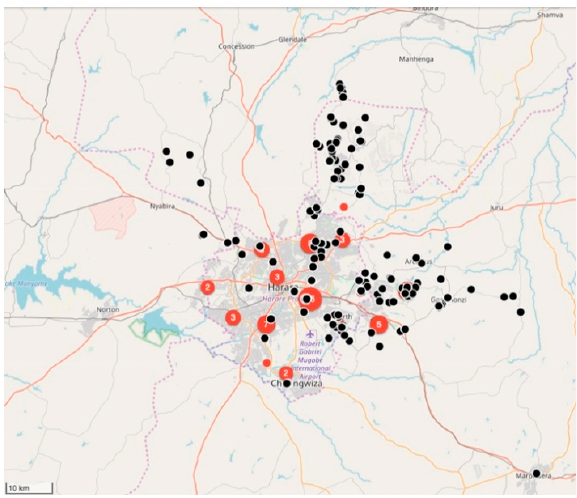
Figure 5. Map of Harare showing the location of laboratory-confirmed rabies cases (red dots) and locations of vaccinated animals (black dots) in 2018. The number of rabies cases per location is displayed in terms of the size and the number within each red dot. Only the location of the vaccinated animals is displayed on the map (black dots) for ease of interpretation. On this specific map, the total number of black dots represent the 9617 animals vaccinated between February 2018 and December 2018.